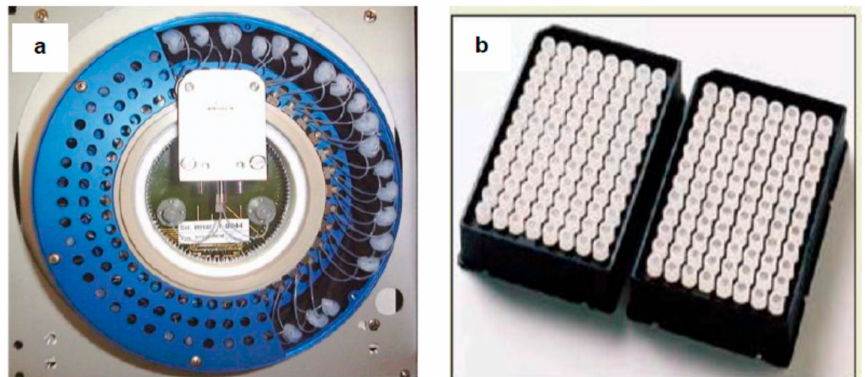
Figure 4. ( a ) Removable loop cassette for 36 sample loops (the position of eluted peaks in each loop is monitored by memory board sits in the center); ( b ) two units of Spark Holland solid phase extraction (SPE) Unit with 96 SPE cartridges (robot gripper is used to monitor the eluted peaks position in SPE cartridges).